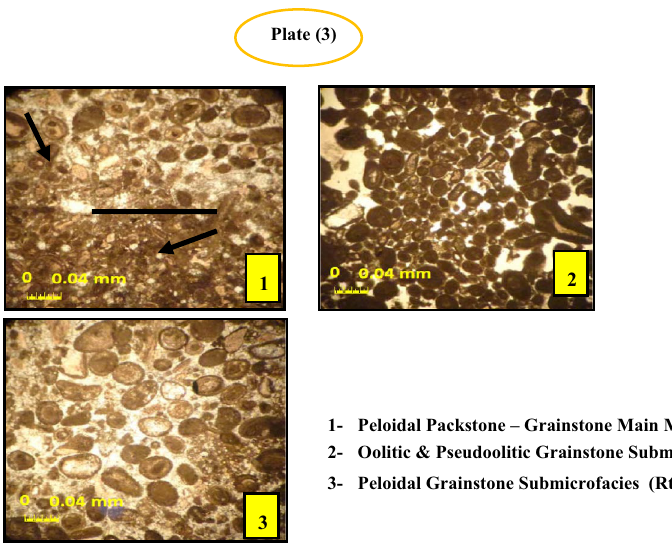
Figure 8. The proposed sedimentary model for Yamama Formation in Ratawi field for the current study by using Didger 3 software for drawing the graphic and compare it to the main ideas references that have been mentioned in the depositional model. So, the current study’ proposed sedimentary model was based on the typical microfacies distribution model of Wilson 2 and the sedimentary model of the carbonate ramp proposed by Ahr 30 and Read 31 . The final form will be as seen in Fig. 8. Has been added author legend depending on spreading author petrographic constituents of microfacies. Also, it has been put the related Wilson standard microfacies (SMF) depending on author main microfacies and submicrofacies distribution in the model, and the related environmental facies zones (EFZ) depending on author main microfacies and submicrofacies environments. Modified the ideas of the distribution related to each one exactly to match it depending on author model sample and